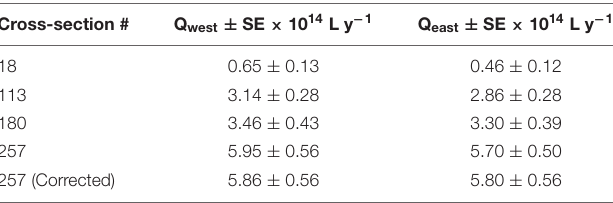
TABLE 1 | Cross-sectional mean water exchange transports and standard error of the means, arranged by westerly flow (Qwest), and easterly flow (Qeast). Cross-section